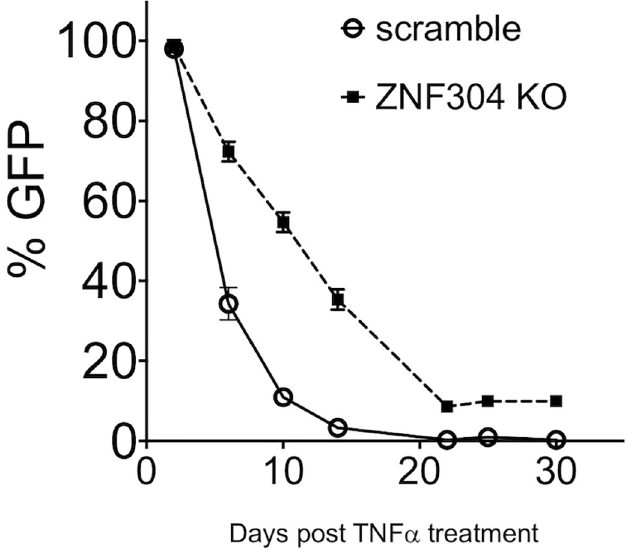
Fig 7. Depletion of ZNF304 expression delays the establishment of HIV latency. Control (circles and solid line) and ZNF304-depleted 2D10 cells (squares and dashed line) were treated with TNF α , and 24 h post cell activation infected cells were sorted based on their GFP expression (day 0). Cells were then grown for the indicated days post infection to allow them to gradually enter viral latency. GFP expression was monitored at the indicated time points by FACS analysis as a reference for entry into viral